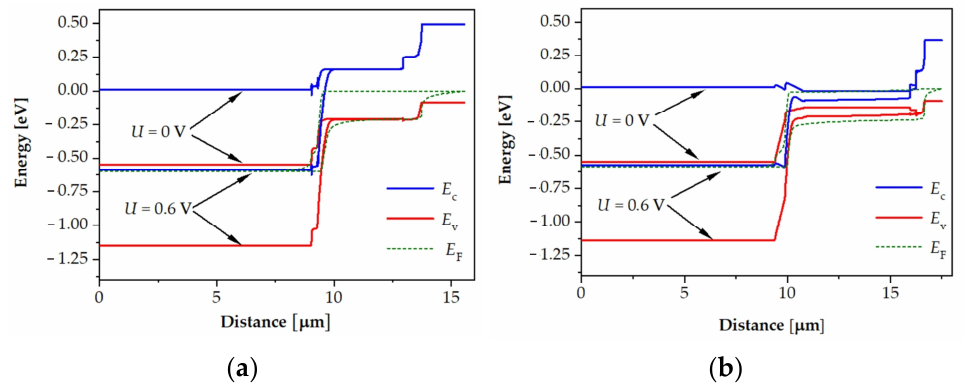
Figure 5. Energy band diagram for the SWIR ( a ) and LWIR2 ( b ) structures with and without bias voltage at temperature T = 300